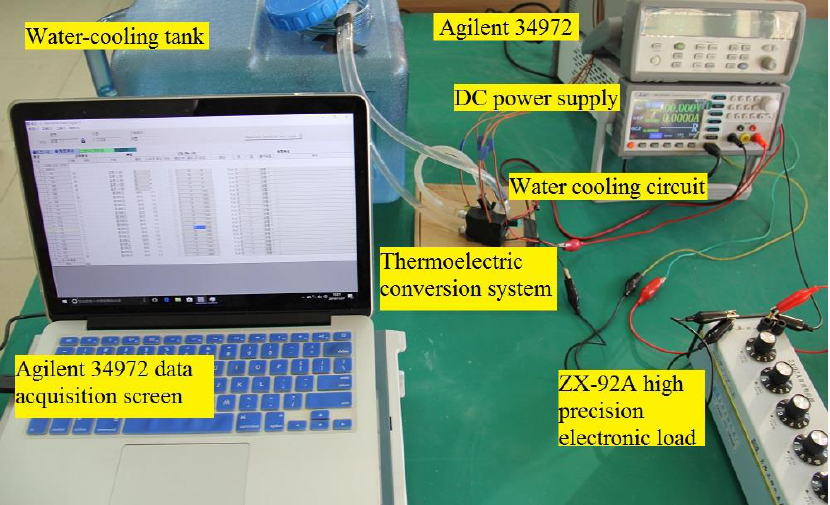
Figure 2. Experimental rig of thermoelectric energy conversion system for heat recovery with circulating energy exchange water-cooling circuit.